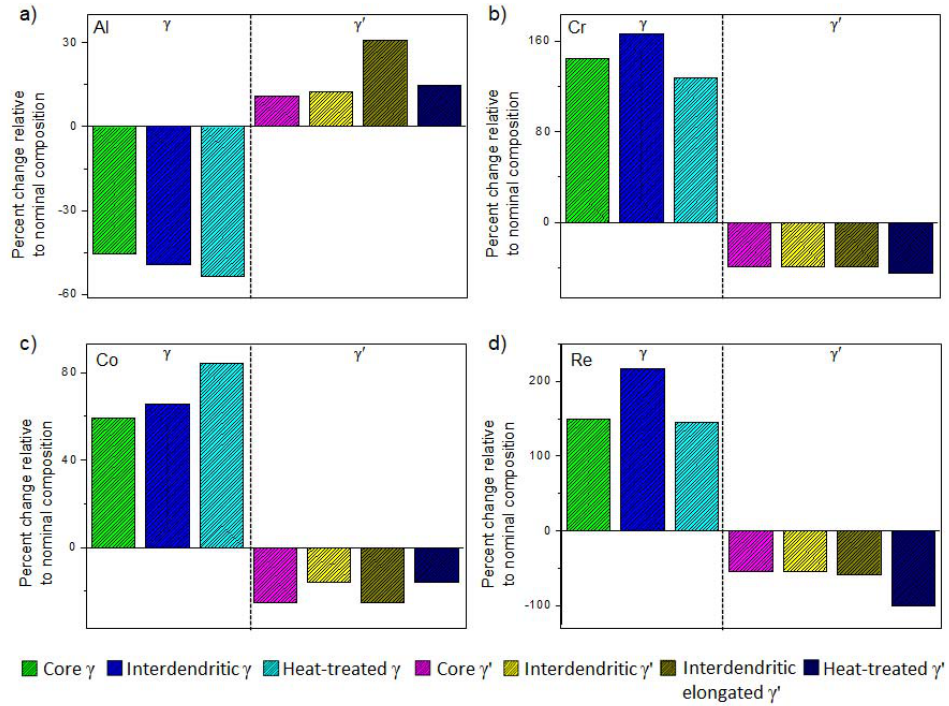
Figure 5. Percent changes relative to nominal composition of ( a ) Al, ( b ) Cr, ( c ) Co, and ( d ) Re based on Table 1.